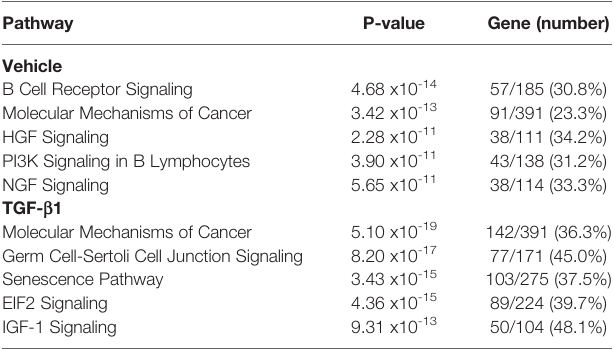
TABLE 2 | The signaling pathways most affected by LMTK2 KD in CFBE41o- cells treated with TGF- b 1 or vehicle control. Pathway P-value Gene (number) Vehicle B Cell Receptor Signaling